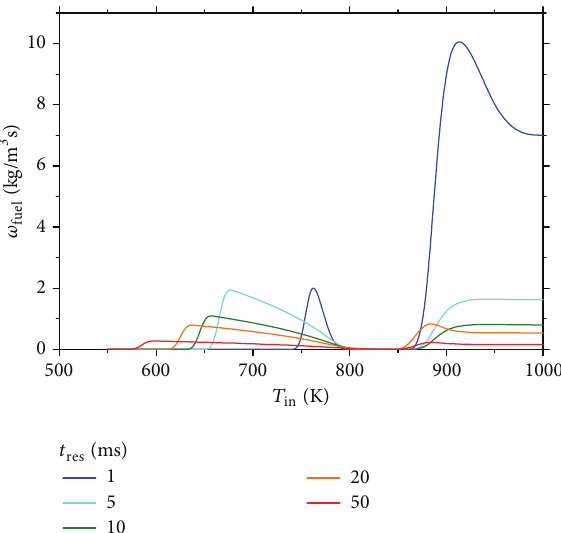
Figure 7: Predictions of fuel consumption rate per unit volume as a function of inlet temperature for 5 characteristic values of residence = 0.06 time ( 𝑌 fuel